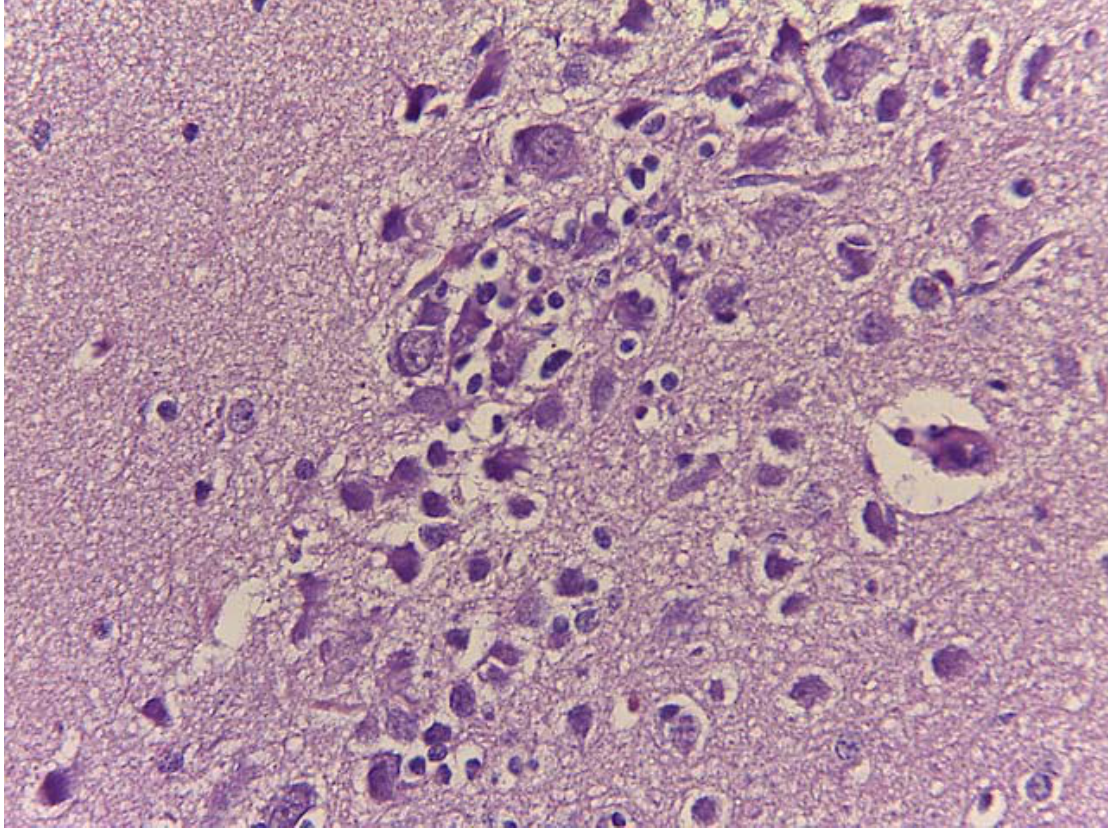
Figure 7. Neurons shrunken and degenerated surrounded by a reactive glia. H&E. Magnification: 40×.